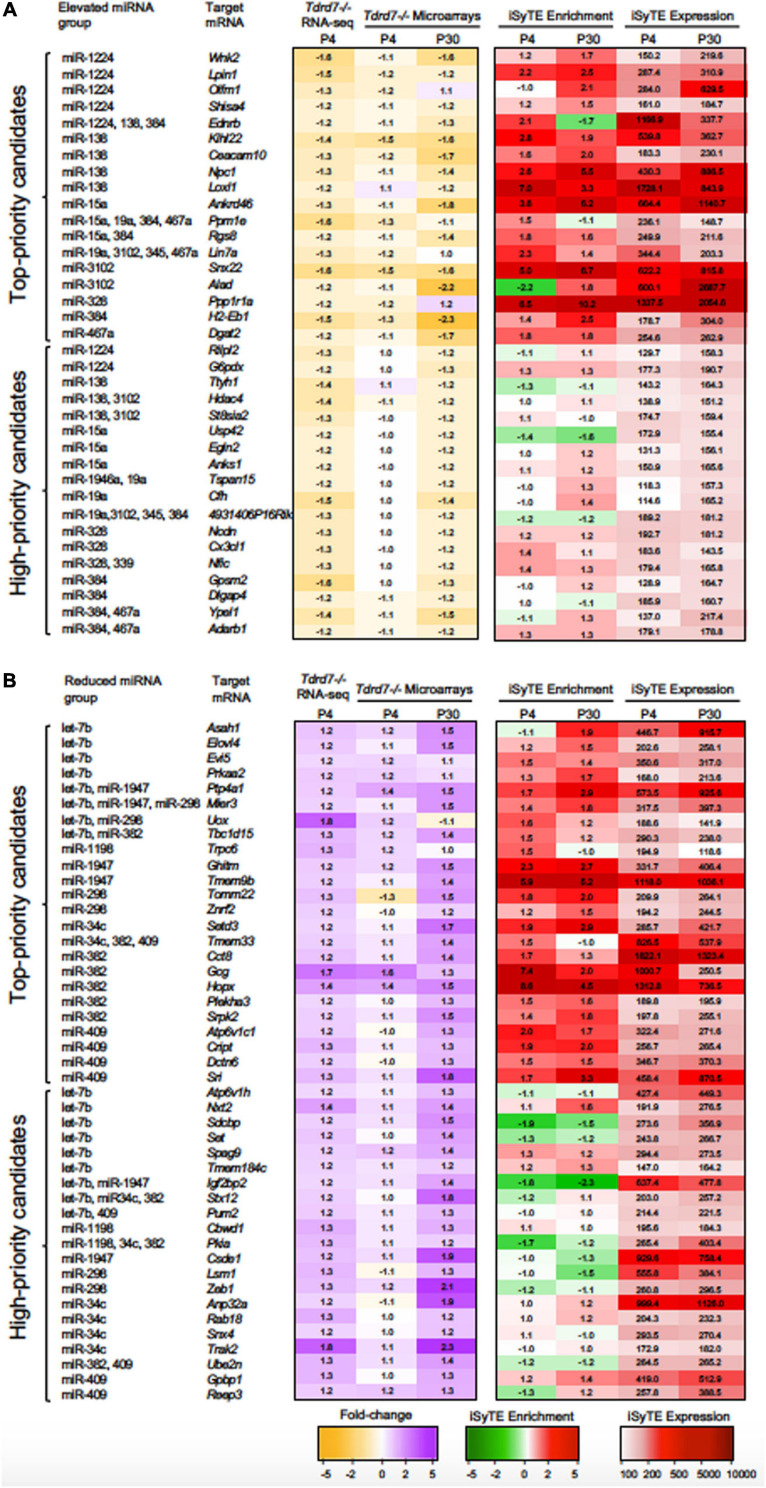
“Top-priority” and “High-priority” mRNA targets of Tdrd7-downstream miRNAs in the lens. Heat-maps representing expression data of “Top-priority” and “High-priority” mRNA targets of miRNAs identified in (A) “Elevated miRNA group” and (B) “Reduced miRNA group” in Tdrd7-/- lens. Differential expression in P4 (RNA-seq and microarray data) and P30 (microarray data) in Tdrd7-/- lens (left) and enriched expression and expression in normal lens as per iSyTE data at postnatal day (P) 4 and P30 (right). “iSyTE Enrichment” represents lens-enriched expression in fold change, while “iSyTE Expression” represents lens expression in fluorescence intensity units at P4 and P30. The mRNA targets are grouped based on the filtering criteria outlined in the text and in Figure 3C. Heatmap keys indicate the following: Yellow and purple color gradient represent low to high differential expression in Tdrd7-/- compared to control lens (in Fold-change) in RNA-seq data and microarray data. Green and red color gradients represent low to high lens-enrichment (in Fold-change) in iSyTE microarray data. Light-red and red gradients represent low to high lens-expression (in fluorescent intensity units) in iSyTE microarray data.